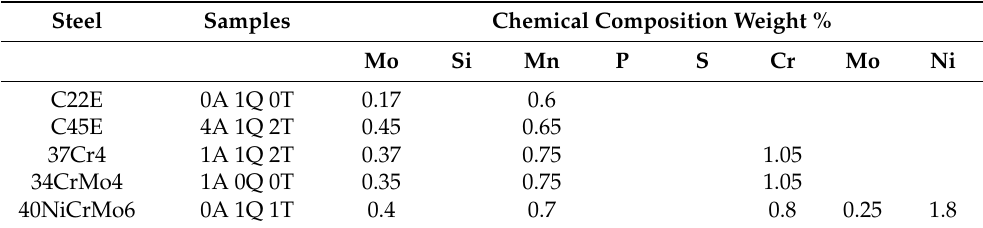
Table 1. Chemical composition (weight %) of low-carbon steel samples according to ISO 683-1:2019 and ISO 683-2:2019 standards. Number of samples for each heat treatment: annealing (A), quenching (Q) and tempering